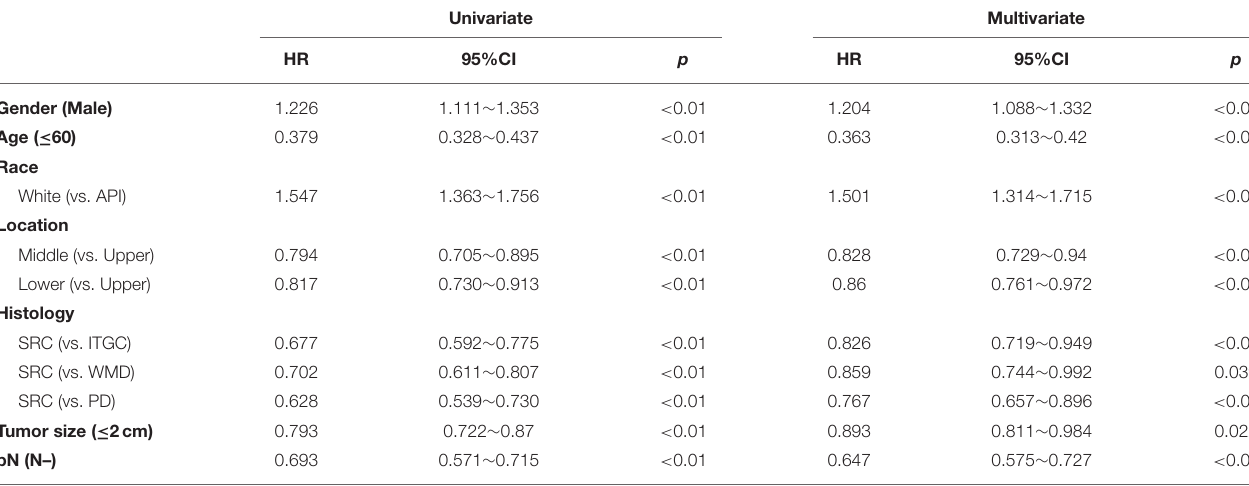
TABLE 3 | Univariate and multivariate analyses of prognostic factors for overall survival in early gastric cancer. Univariate Multivariate HR 95%CI